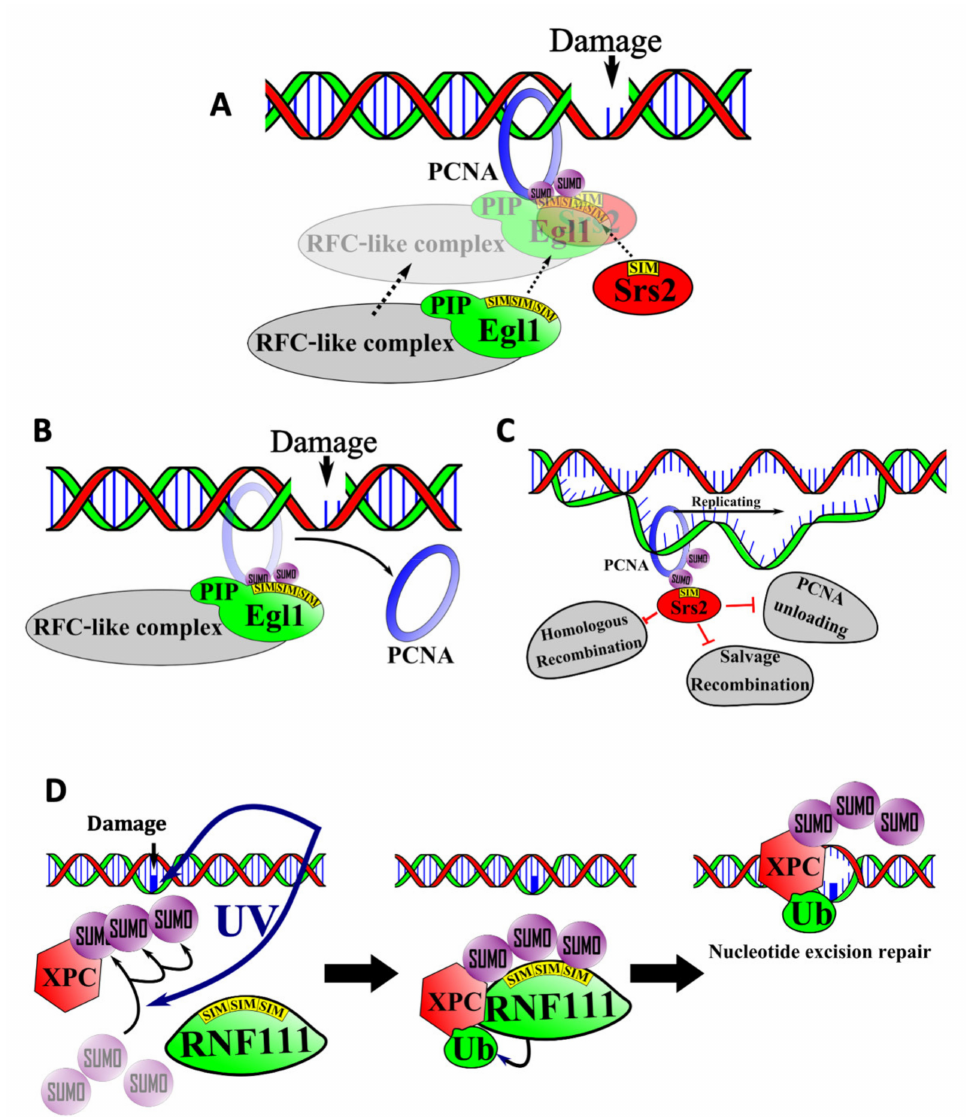
Figure 3. Roles for SUMO/SIM interactions in DNA repair. ( A ) The Elg1/RFC-like complex SIMs and the Srs2 SIM compete for binding to SUMOylated PCNA. ( B ) When the Elg1/RFC-like complex SIM interacts with SUMOylated PCNA, the PCNA is unloaded from the DNA, preventing accumulation of PCNA on the DNA and further DNA damage. ( C ) When the Srs2 SIM interacts with SUMOylated PCNA, the interaction inhibits the Elg1-mediated unloading of PCNA, homologous recombination, and the salvage recombination pathway. ( D ) The SIMs in RNF111, a SUMO-targeted ubiquitin ligase, interact with SUMOylated XPC to catalyze its nonproteolytic ubiquitylation, which activates the nucleotide excision repair